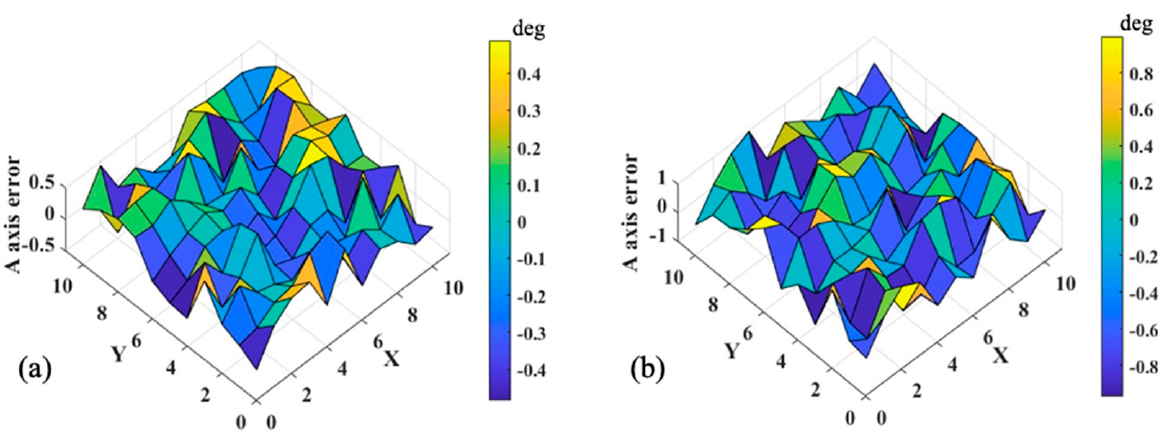
Figure 5. Normal-error distribution of polishing tools used in group ( a ) B and ( b ) C polishing ex- periments.